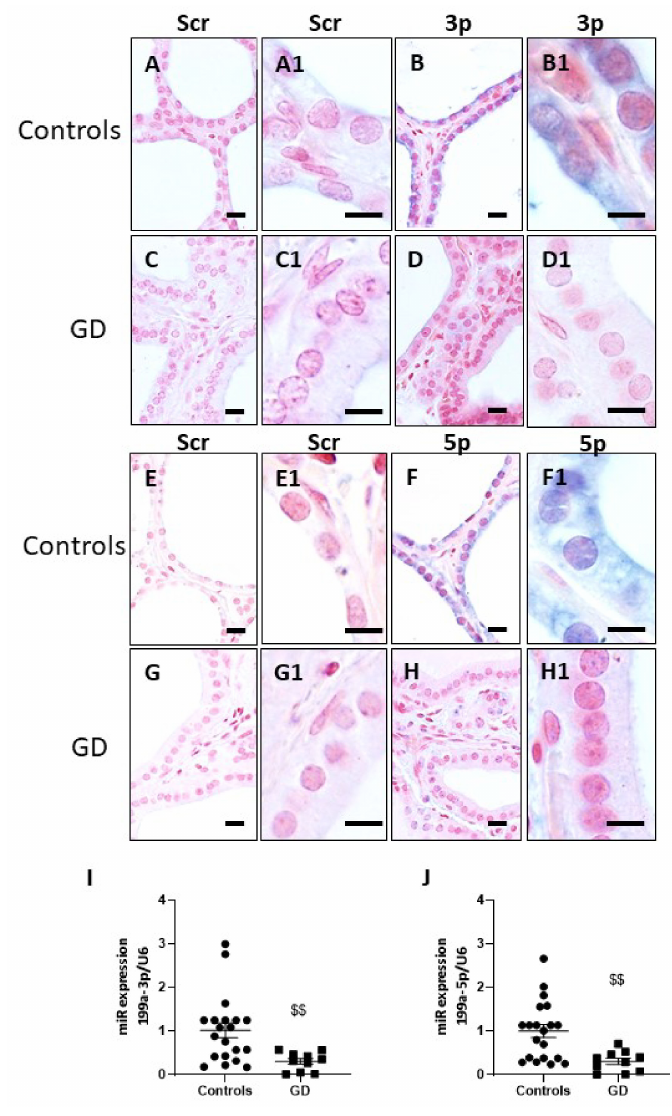
Figure 5. miR-199a family is downregulated in GD thyrocytes. In situ hybridization of LNA TM probe Scramble-microRNA ( A , C , E , G ), of miR-199a-3p ( B , D ) and of miR-199a-5p expression ( F , H ) in control and GD thyroids. Note the weak staining in GD thyrocytes compared to controls ( A1 – H1 ). Scale bars = 10 µ M. Measurement of miR-199a-3p and-5p by qRT-PCR showed a significant decrease of both miRs in GD thyroids ( I , J ). The data were normalized with the data of U6 snRNA. Data represent the mean ± SEM from 20 controls and 10 GD thyroids, $$ p < 0.01 compared to